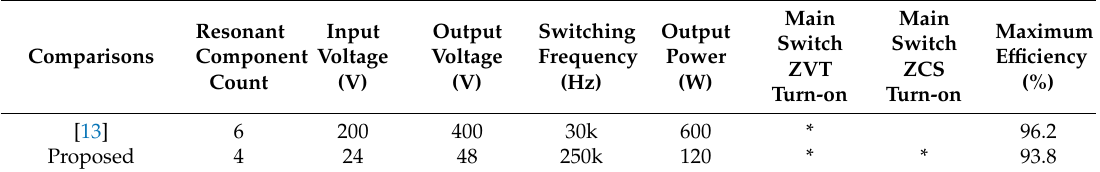
Table 2. Comparisons between [13] and the proposed circuits (ZVT: zero-voltage transition; ZCS: zero-current transition).